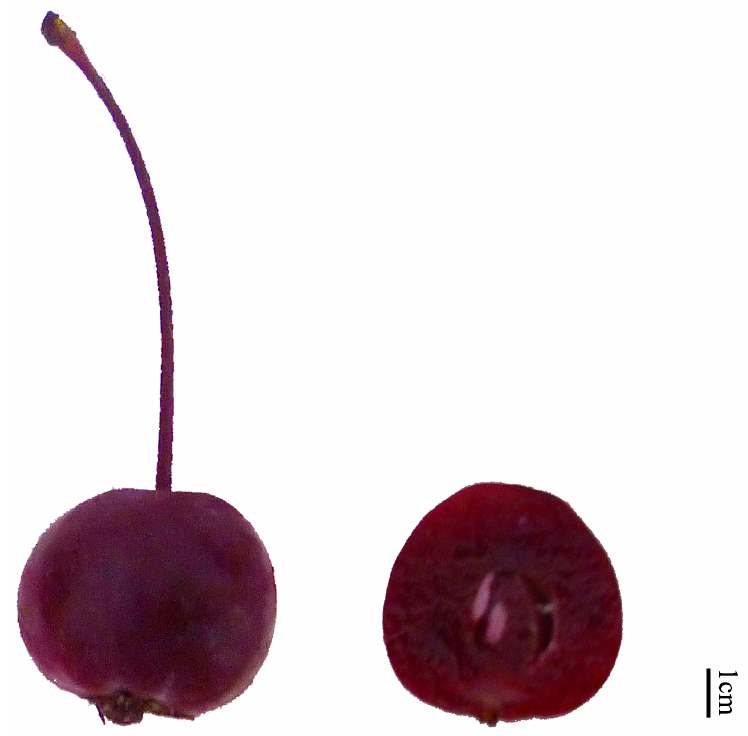
Figure 1. The morphology of Malus ‘Royalty’